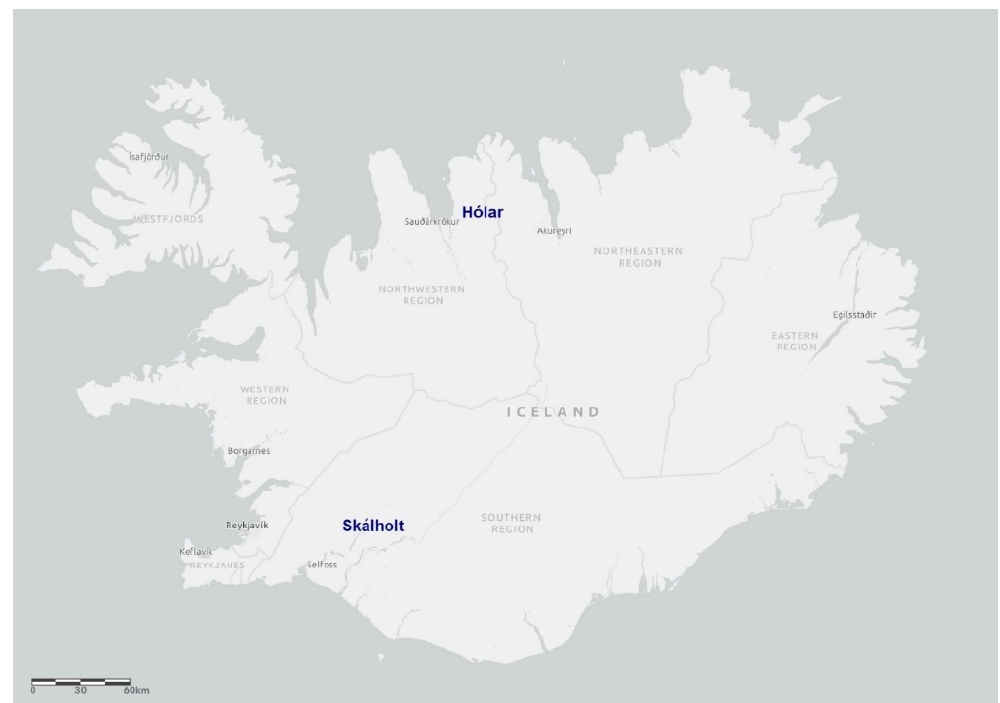
Figure 1. Map of Iceland, showing the two episcopal sees: Skálholt and Hólar. The diocese of Skálholt encompassed the Western, Southern and Eastern Regions, while Hólar encompassed the Northern Region.